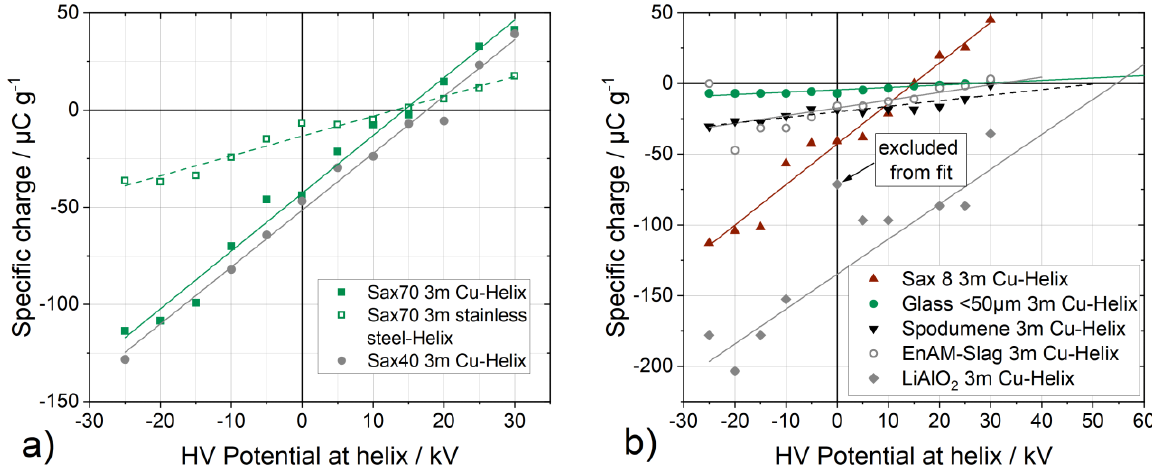
Figure 6. ( a ) Net charge for combinations of limestone with different helix materials (copper and steel). ( b ) Net charges for combinations of different particle materials with the copper helix. Uncertainties in the slope and the PZNC values for the different materials are: Sax 70: Slope: ±13%, PZNC: ±9%; Sax 40: Slope: ±12%, PZNC: ±9%; Sax 8: Slope: ±0.17%, PZNC: ±0.45%; Glass: Slope: ±11%, PZNC: ±17%; Lithium aluminate.: Slope: ±50%, PZNC: ±6%; Spodumene: Slope: ±1%, PZNC: ±10%.